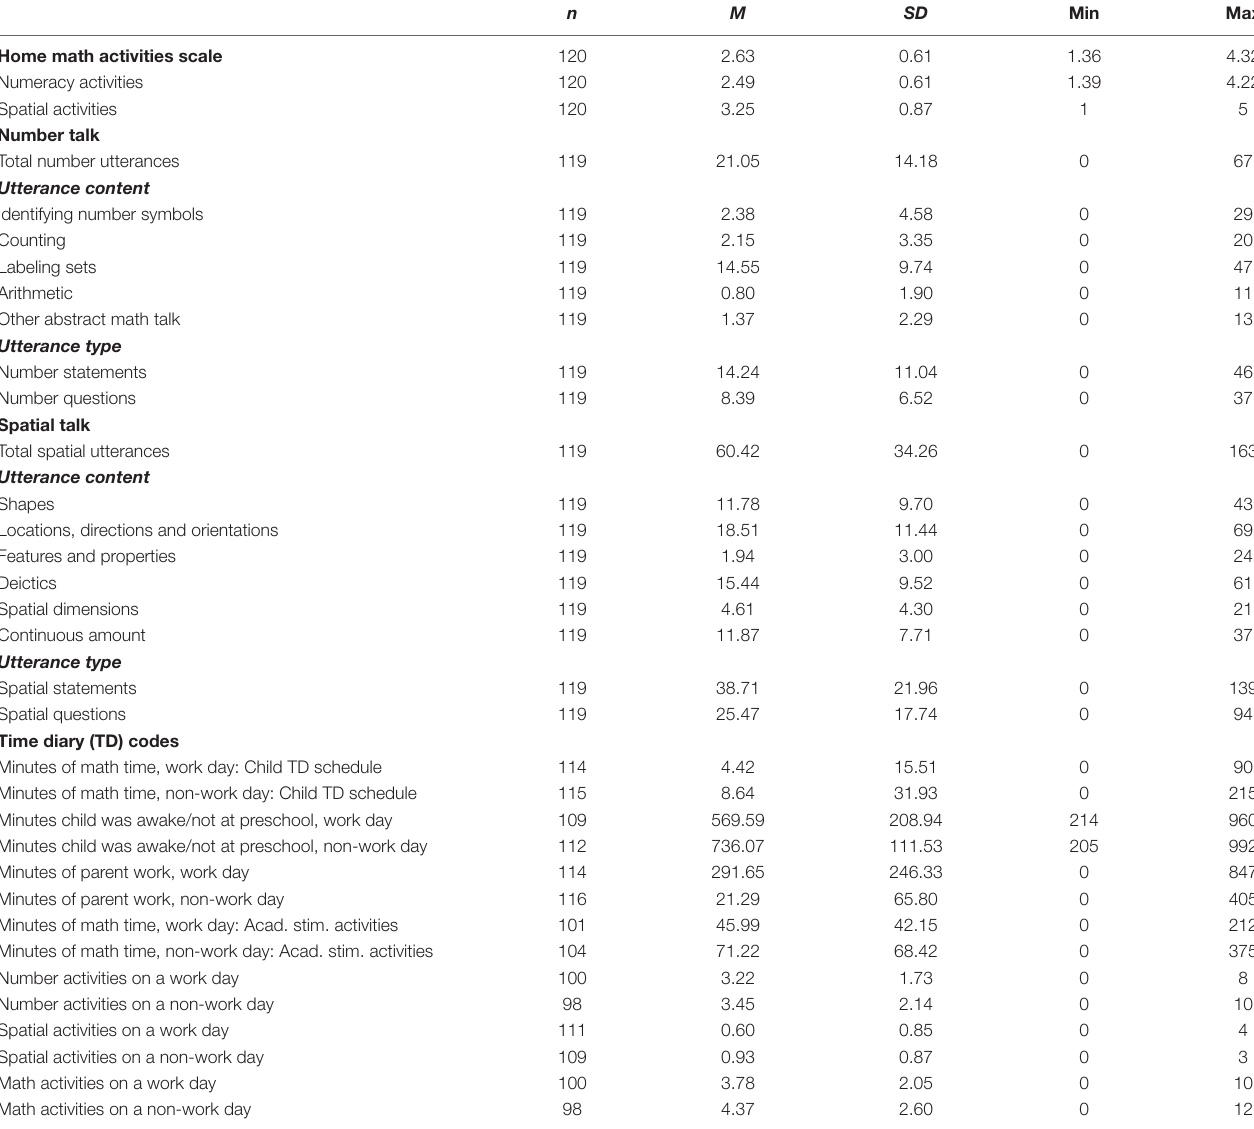
TABLE 5 | Descriptive statistics for parental math support